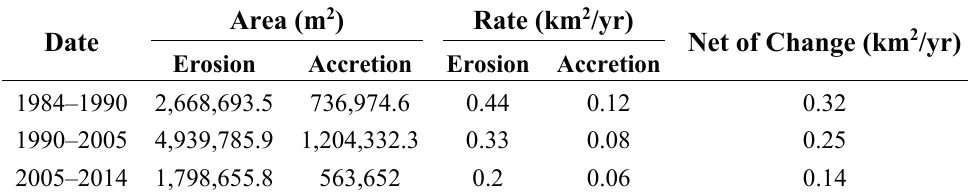
Figure 8. The post-classification change detection image, for ( A ) 1984–1990, ( B ) 1990–2005 and ( C ) 2005–2014 at Rosetta Promontory. Table 4. Accreted and eroded areas at Rosetta Promontory between 1984 and 2014 using combination of histogram threshold of Band 5 and Band ratio (B2/B5),